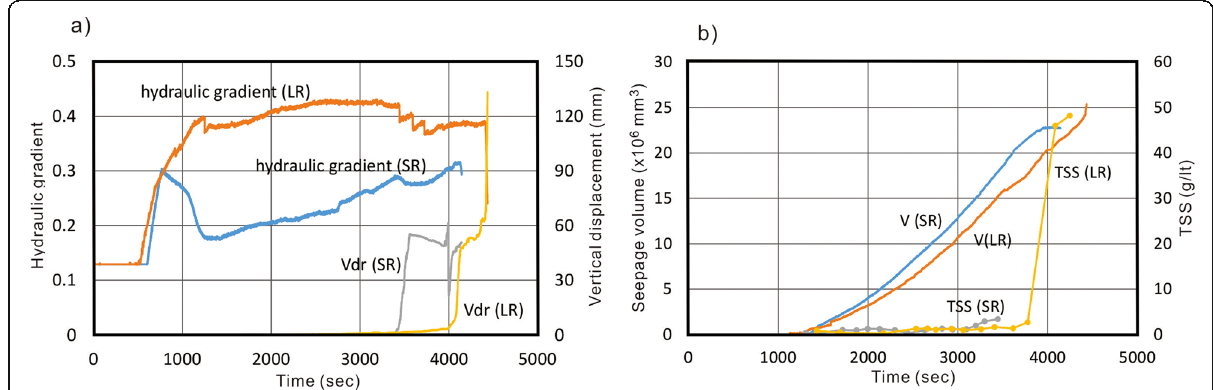
Fig. 9 Time series data of hydraulic gradient, vertical displacement, seepage volume and TSS for the sample S456 at a small reservoir (SR) and large reservoir (LR). a Hydraulic gradient and vertical displacement; b Seepage volume and TSS